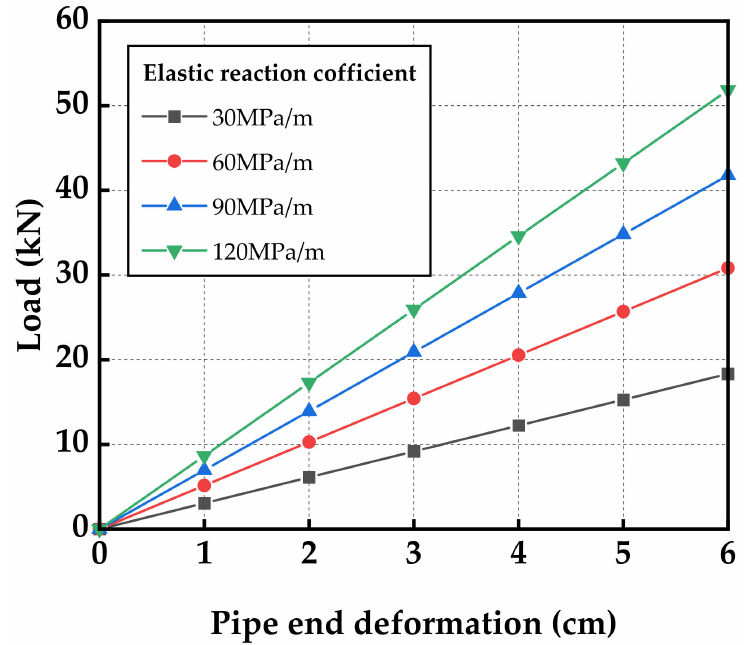
Figure 6. Deformation-load characteristics of FLSP with different foundation reaction